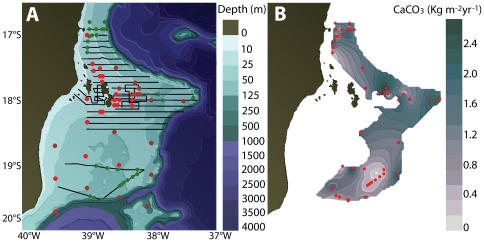
The study region off eastern South America, Abrolhos Bank.(A) Bathymetric map showing the areas surveyed with SSS (black lines), ROV ground truth sites (red dots) and mixed-gas dive collecting sites (green dots). (B) Distribution, and annual calcium carbonate production of rhodolith beds. The gray area indicates the total area occupied by the rhodolith beds, whereas the gray scale variations correspond to estimates of the annual calcium carbonate production (expressed as kg m−2 yr−1).